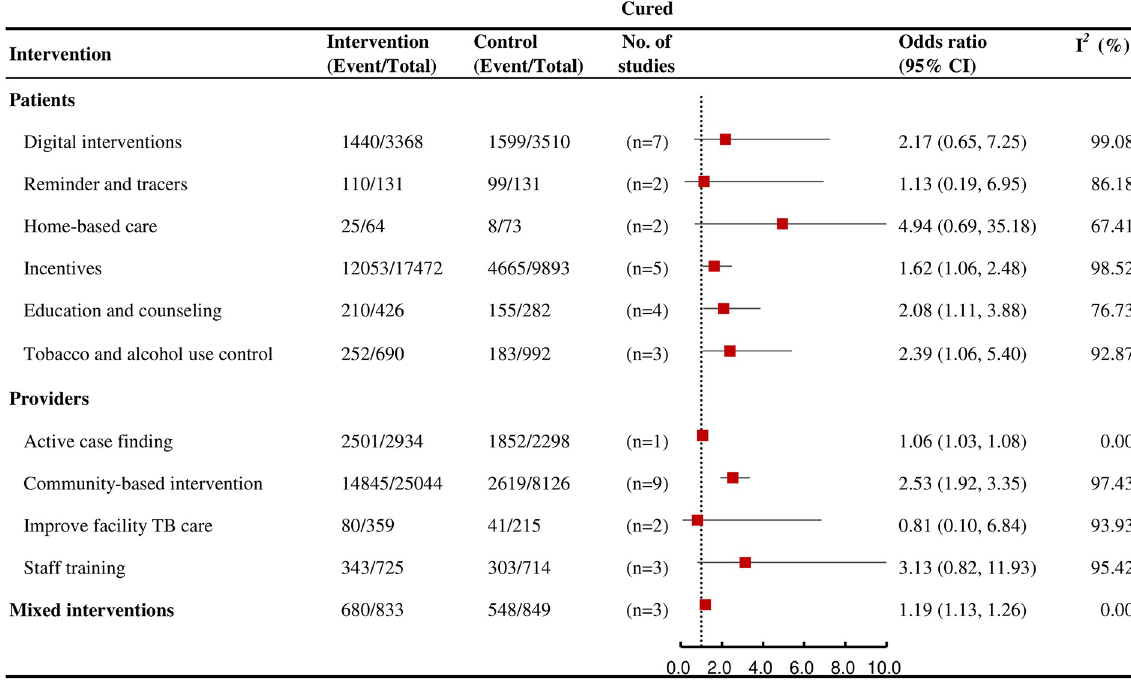
Fig 6. Forest plots showing the effects of various interventions on TB cure outcomes for active TB.